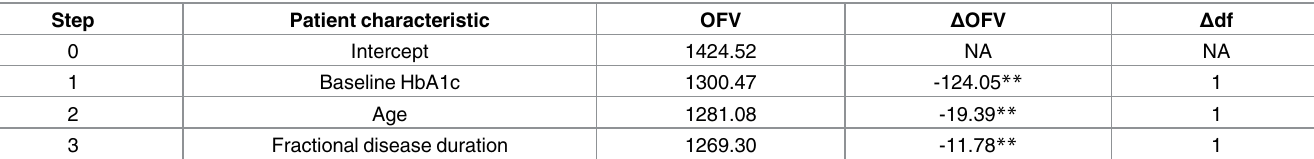
Table 2. Stepwise model building results.